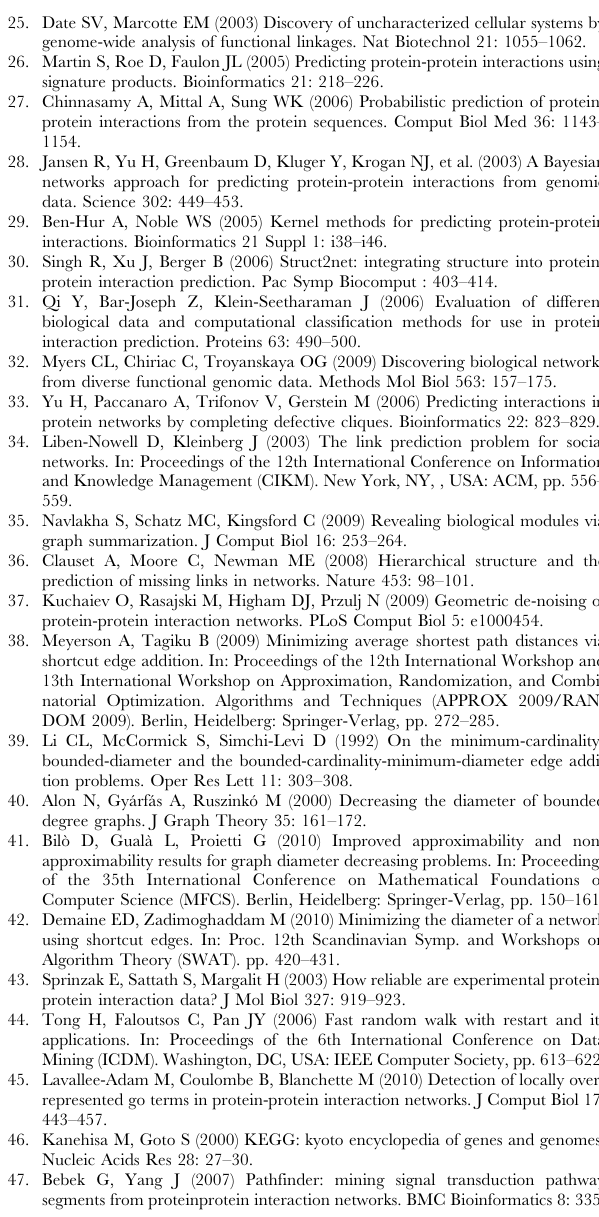
Table S1 List of affected genes following TPK2 knock-